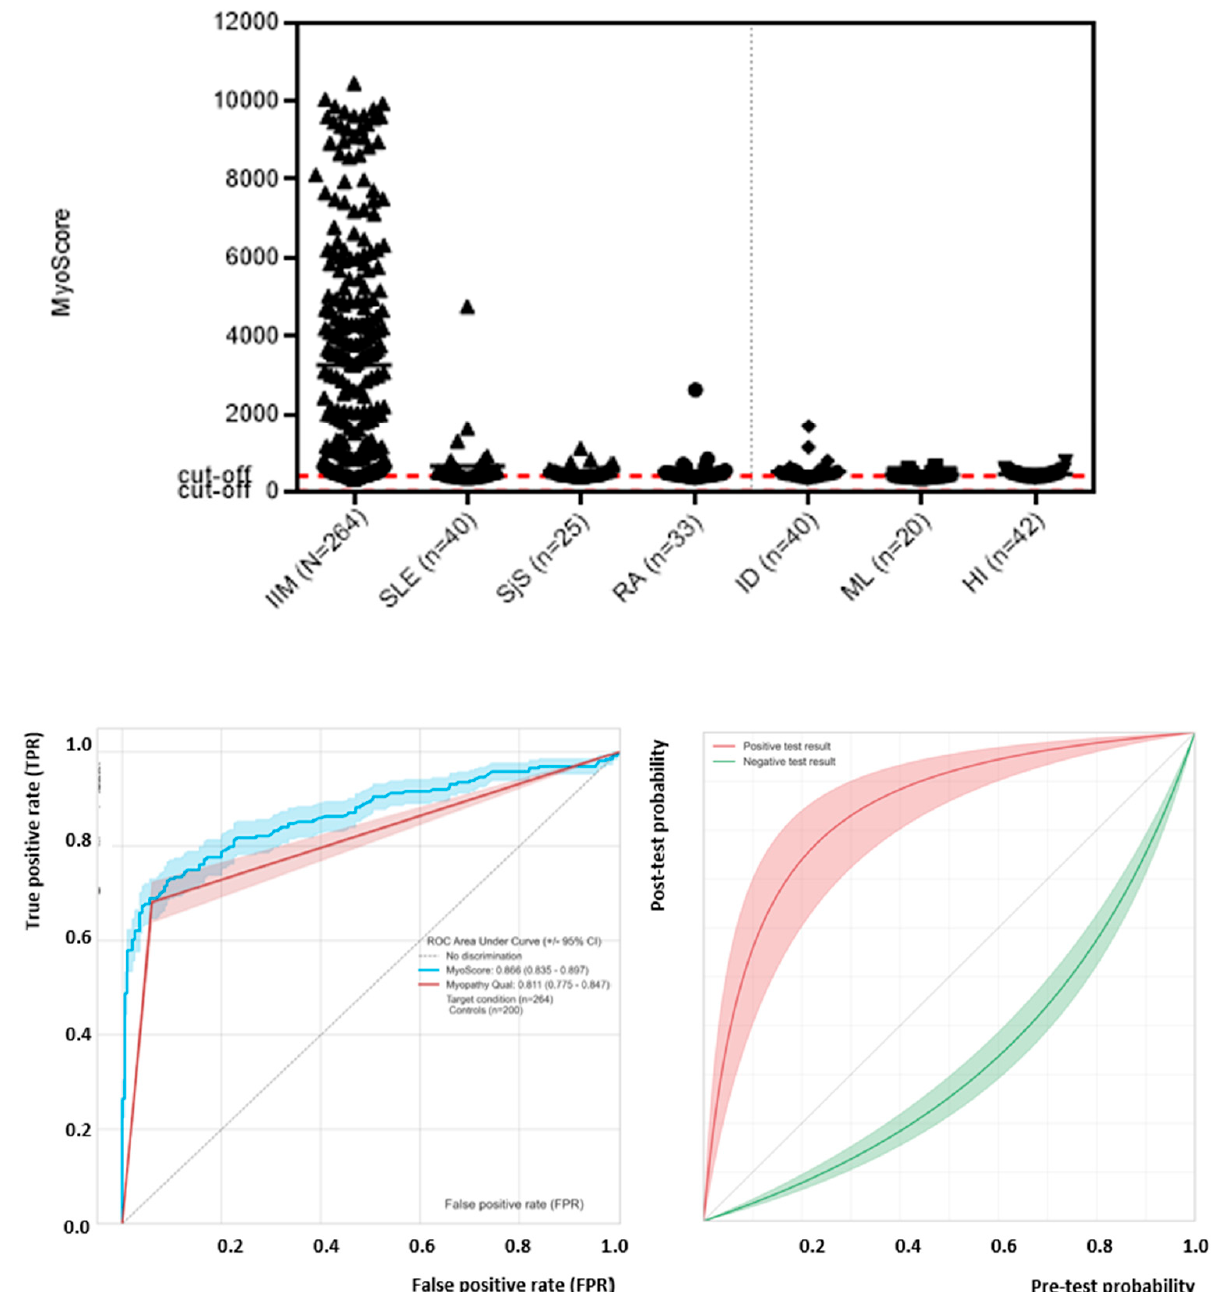
Figure 3. Performance of the MyoScore for idiopathic inflammatory myopathy (IIM). Receiver operating characteristic (ROC) analysis showed good discrimination between IIM patients and controls with an area under the curve (AUC) of 0.87. The area under the curve (AUC) was found as 0.87 (0.82–0.90). Precision recall curve shows high AUC. Pre-test and post-test probability curve illustrates impact of test results (positive and negative) derived from the composite score on the probability for